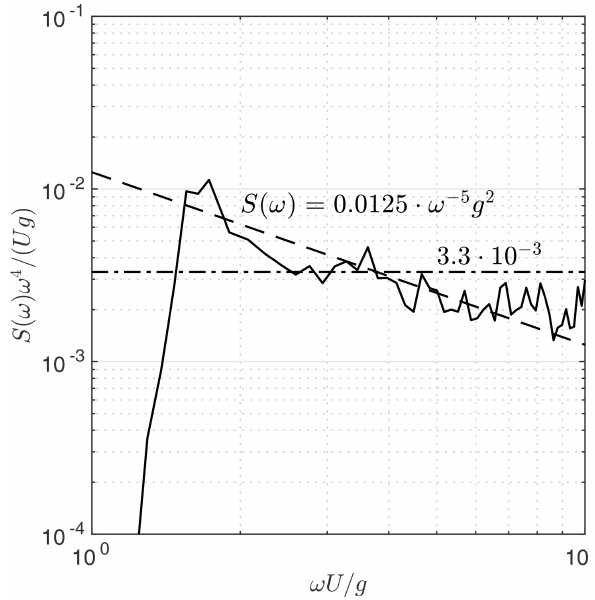
Figure A1. The wave spectrum measured with the Bothnian Sea wave buoy at the height of the storm (1 January 2019 23:00UTC). The spectrum has been scaled assuming a wind speed of U = 27ms − 1 . The equilibrium level (dashed–dotted) and the saturation level (dashed) are also